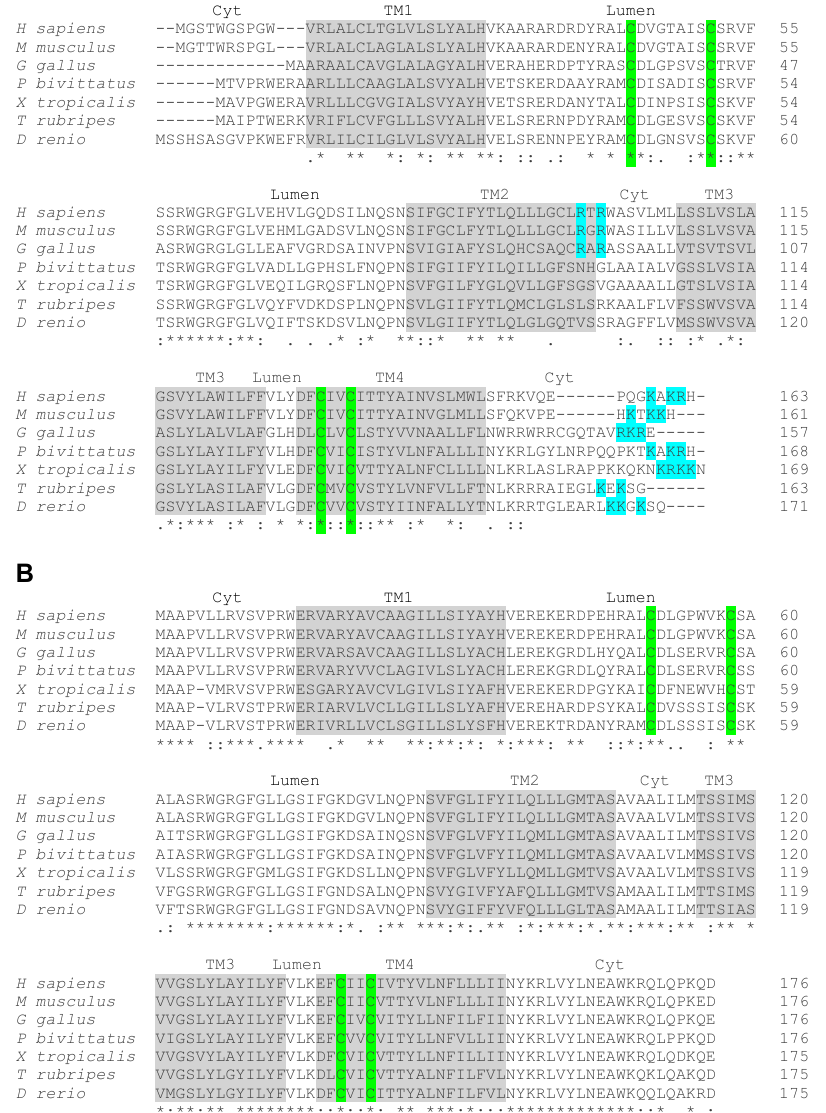
Figure 1. Sequence alignment of vertebrate vitamin K oxido reductases. Vertebrate VKORC1 ( A ) and VKORC1L1 ( B ) sequences from humans ( H. sapiens ), mice ( M. musculus ), chickens ( G. gallus ), Burmese pythons ( P. bivittatus ), clawed frogs ( X. tropicalis ), Japanese puffer fish ( T. rubripes ) and zebrafish ( D. rerio ). The predicted four transmembrane domains (TM 1-4) are highlighted in grey. The localization of the different loops in the cytosol (Cyt) or in the lumen (Lumen) is indicated above the sequences. The conserved four cysteine residues involved in the enzymatic activity of the proteins are highlighted in green. In VKORC1 the c-terminus di-lysine motif and the internal di-arginine motif, potentially involved in ER retention, are highlighted in blue. Consensus symbols are included below the alignment. A single asterisk (*) indicates a fully conserved residue; a colon (:) indicates a strongly conserved residue; and a period (.) indicates moderate or weak